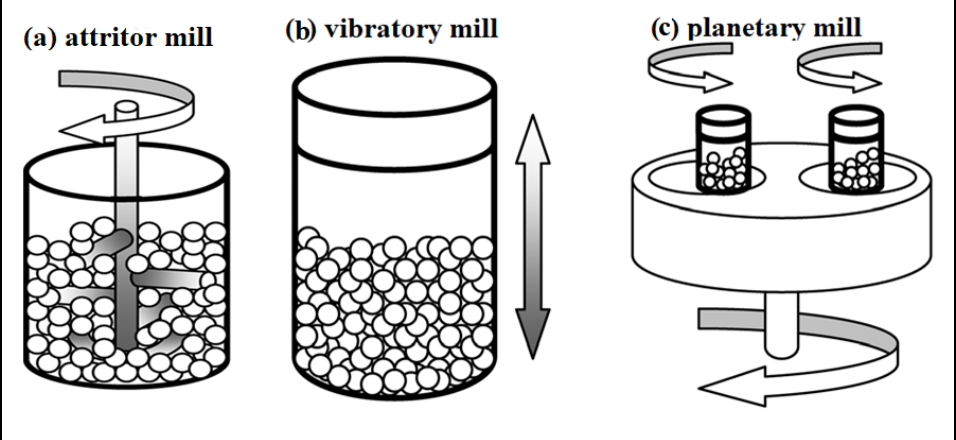
Figure 2. Schematic representation of various types of ball mills [30] “Reprinted/adapted with per-